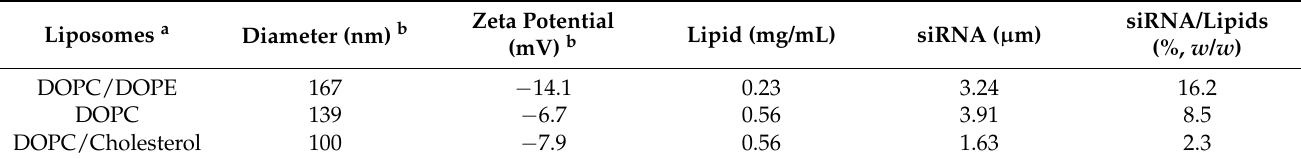
Table 2. Properties of DOPC/DOPE, DOPC, and DOPC/Cholesterol liposomes. Reproduced with permission from